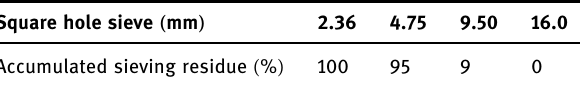
Table 5: Particle size distribution of gravel ( 10 – 20 mm )